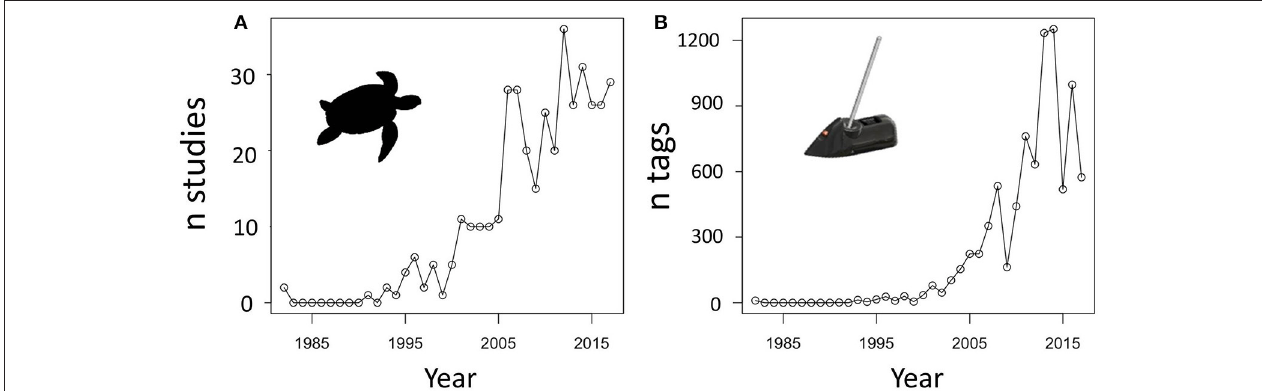
FIGURE 1 | Plots showing the exponential increase in (A) the numbers of sea turtle tracking studies and (B ) the number of unique satellite tags deployed on sea turtles since 1982. Data were collated using the search term “ sea turtle satellite tracking ” in Google Scholar, and excluded University theses, gray literature such as grant reports or conference proceedings (see Appendix 1 for